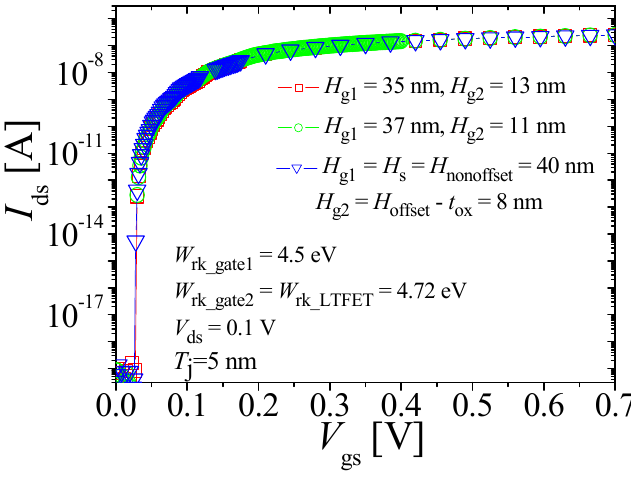
Figure 8. I ds - V gs characteristics for several H g1/2 s with W rk_gate1/2 = 4.5 eV and W rk_gate2 = W rk_LTFET . Red squares, green circles, and blue triangles: H g1 = 35, 37, and 40 nm, respectively.